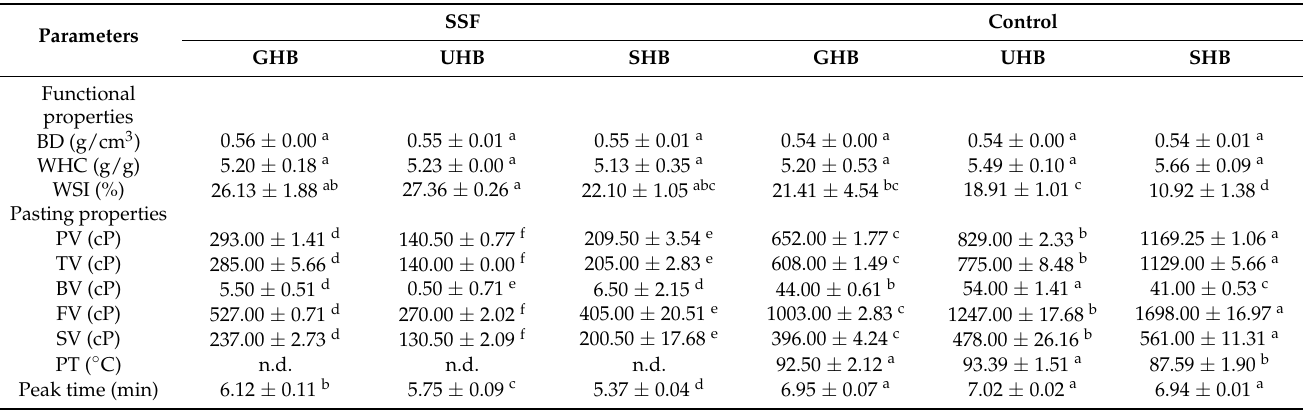
Table 4. Physical properties of the highland barley (the control groups and colonized groups with the mycelia of A. sinodeliciosus var. Chaidam